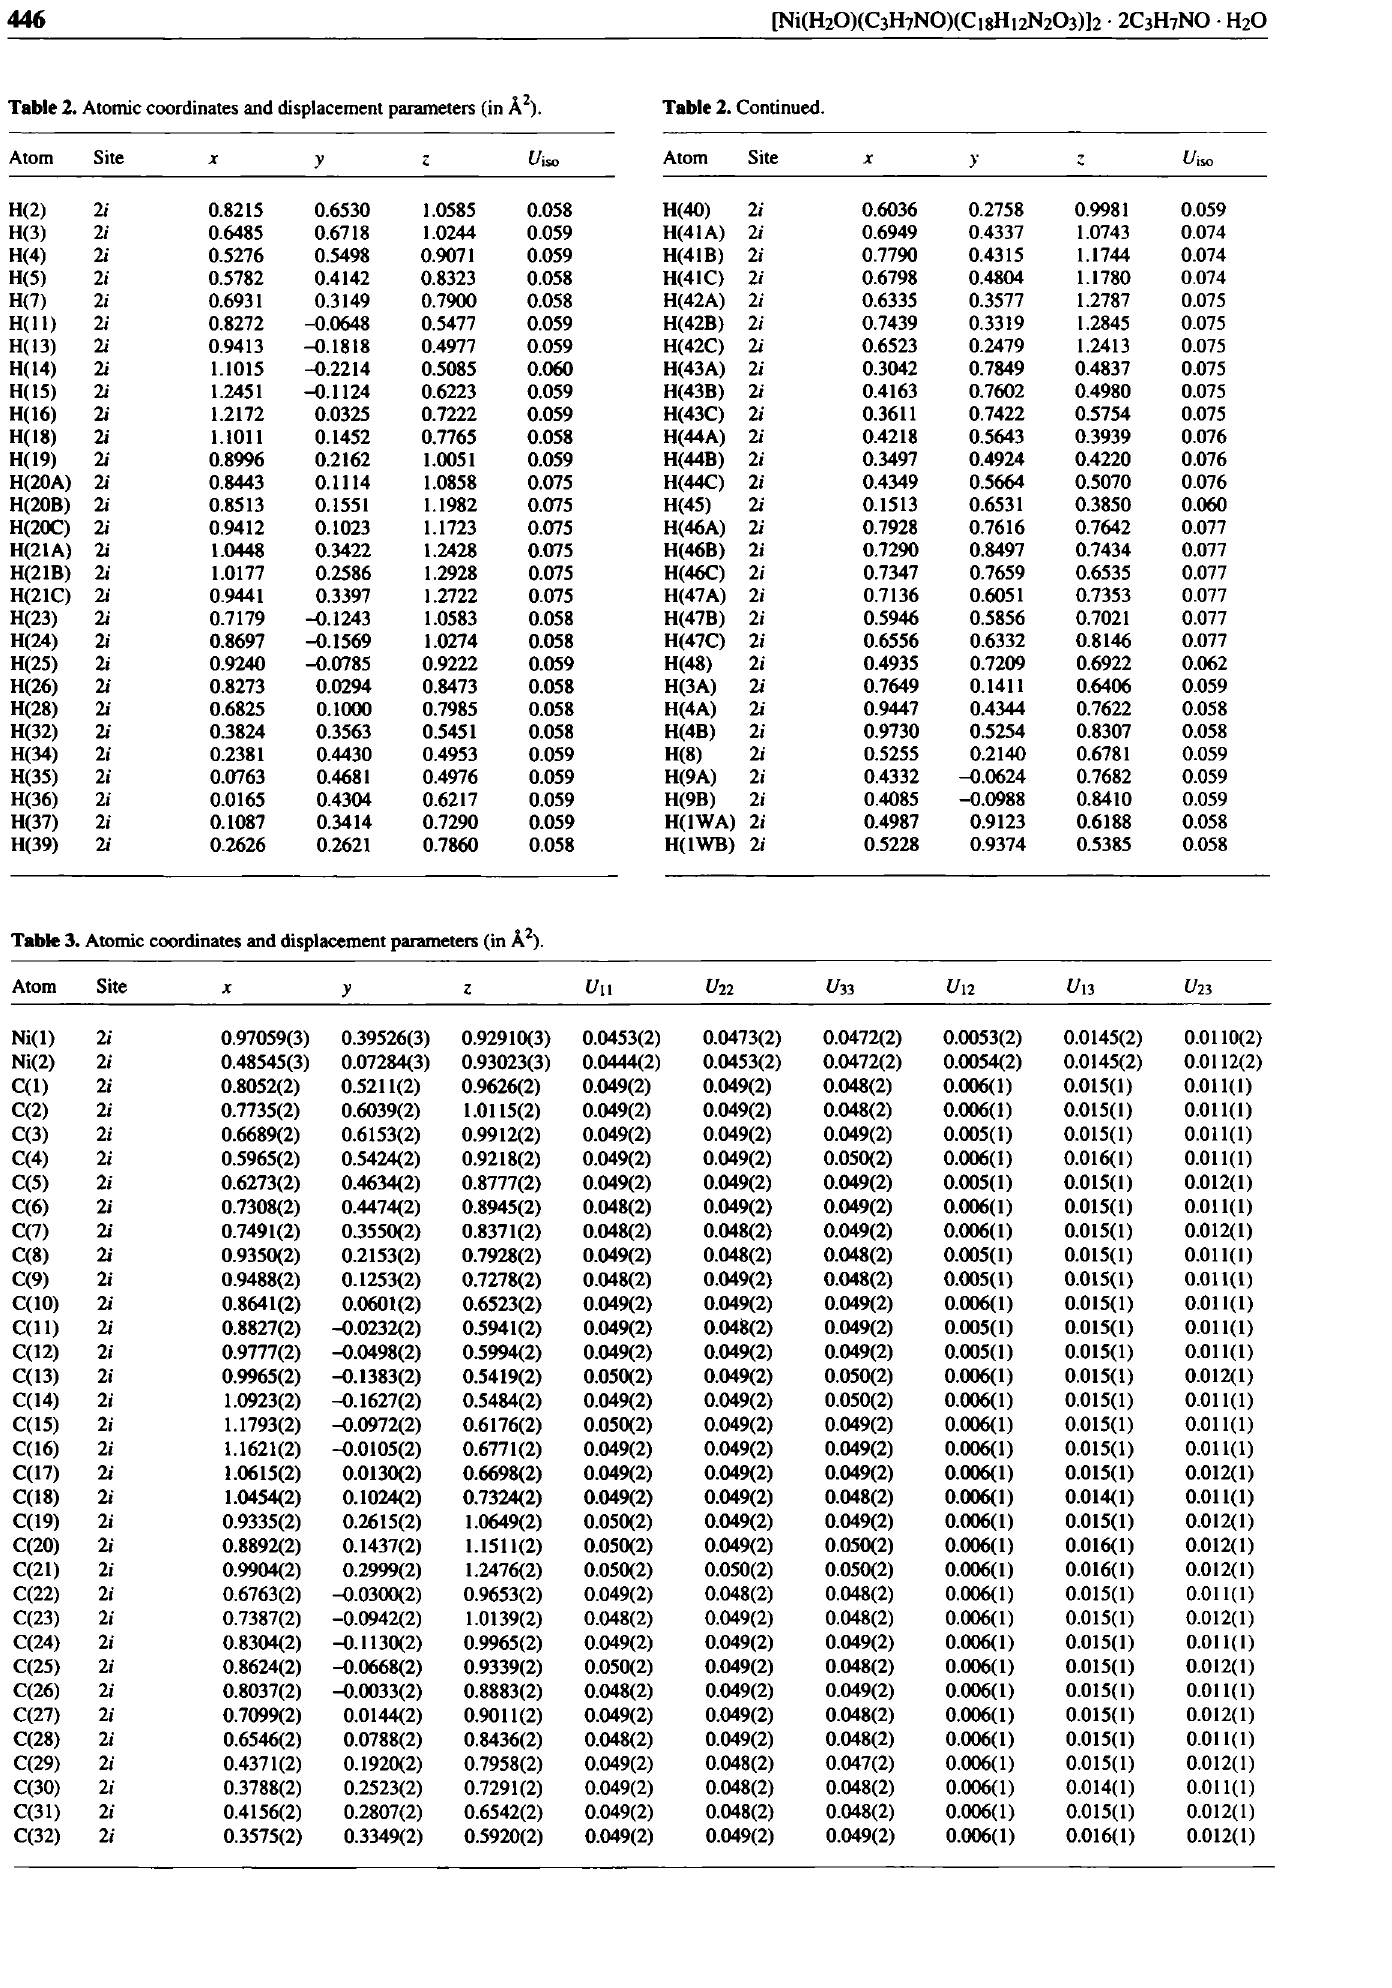
Table 2. Atomic coordinates and displacement parameters (in À 2 ). Table 2. Continued.